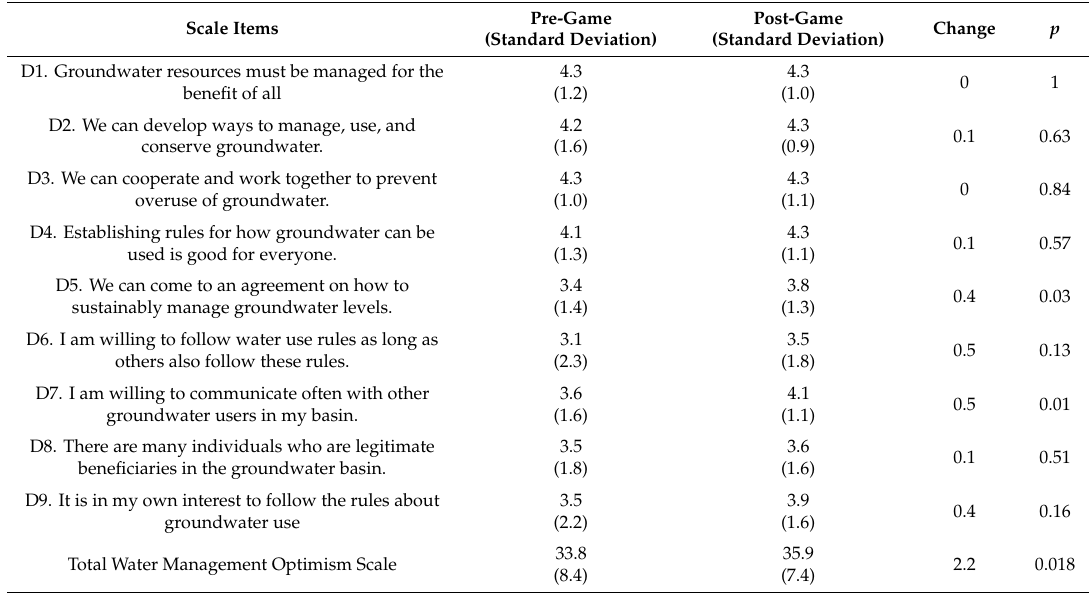
Table 5. Optimism for Water Management, n =